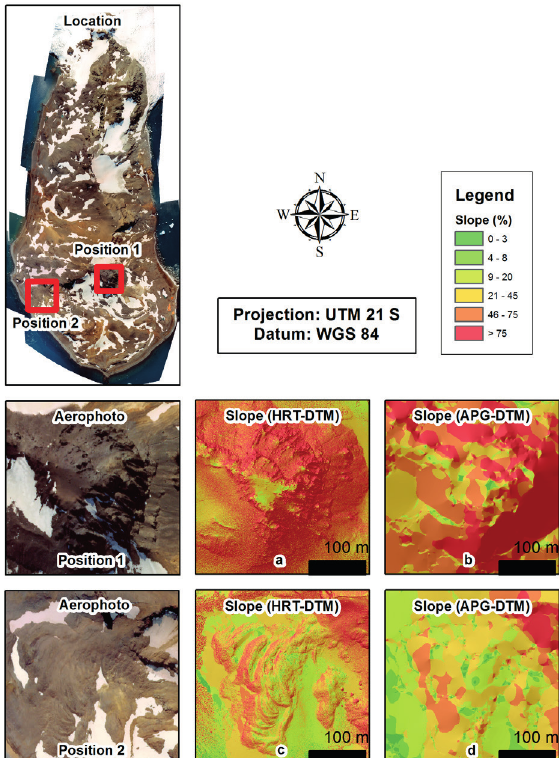
Figure 6 - Illustrative representation of the Aspect for the HRT-DTM (a and c) and the APG-DTM (b and d) in two different positions (Aerophotos adapted from Francelino M.R., unpublished data).